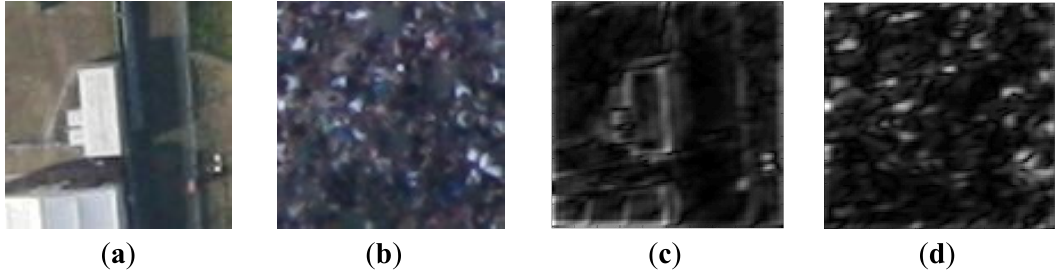
Figure 2. Two original images ( a ) and ( b ) with their respective response images ( c ) and ( d ) after convolving both with a Gabor filter. Subfigure (c) shows the response of the regular structure in the original image (a), while (d) shows the response of the unstructured crowd in the original image